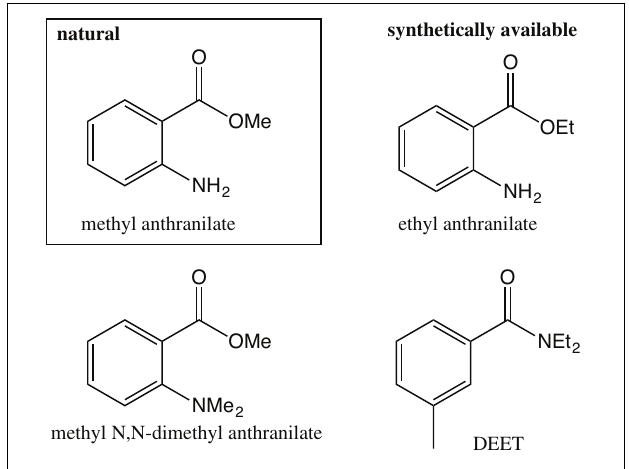
FIGURE 4 | Structure similarity of anthranilate derivatives and